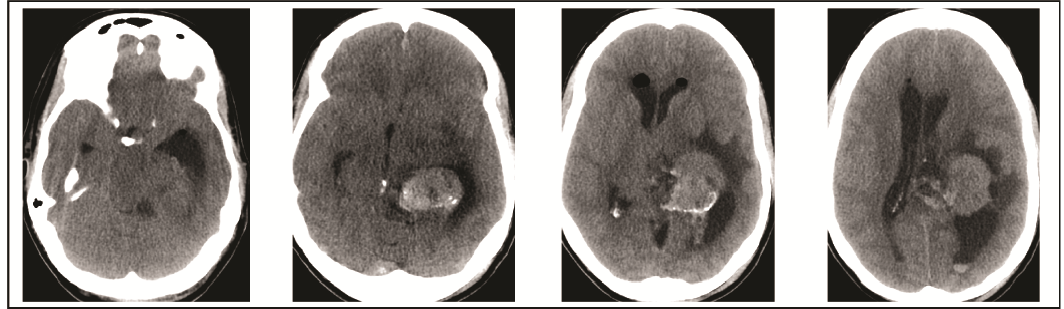
Figure 5. Head CT performed on post-operative day 7 demonstrates increase in cerebral edema, midline shift, and worsened hydrocephalus which prompted operative decompression.